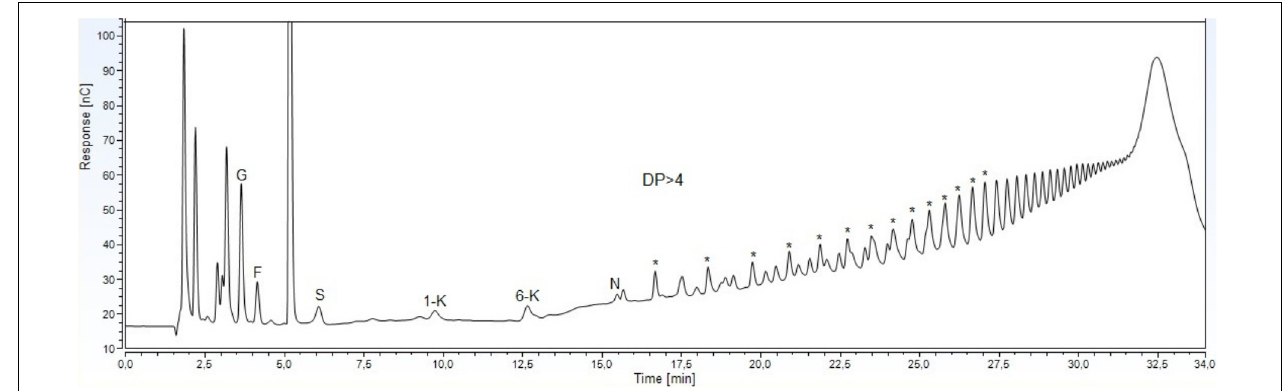
FIGURE 1 | HPAEC-PAD profile of soluble carbohydrates from underground storage system of Gomphrena marginata . Glucose (G), fructose (F), sucrose (S),1-kestose (1-K), 6-kestose (6-K), nystose (N), and fructans with degree of polymerization higher than 4 (DP > 4). The asterisks indicate components of the levan